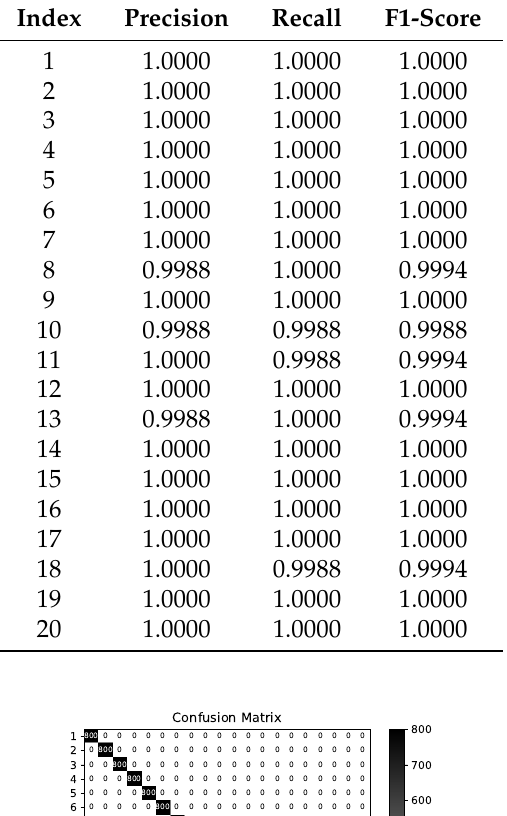
Table 4. Performance of device identification.